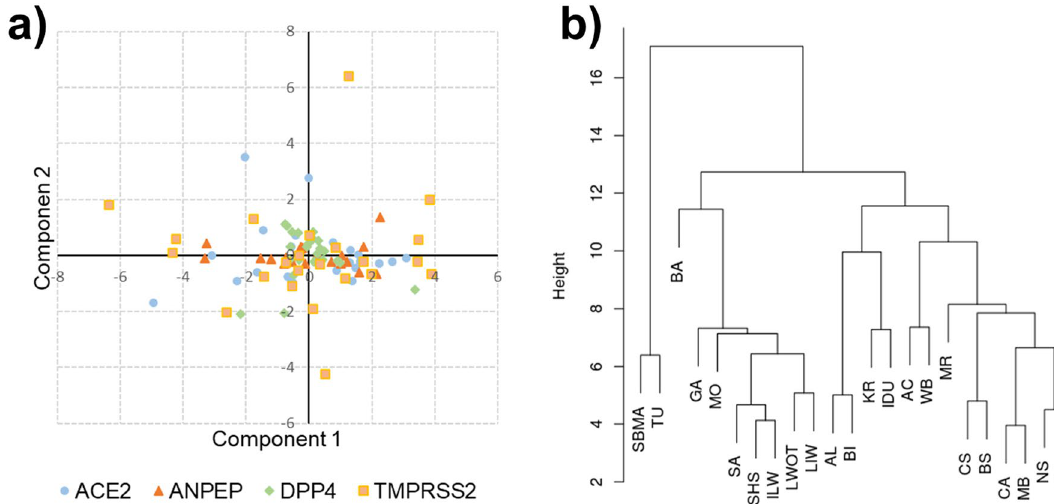
Figure 5. ( a ) Over-imposed multidimensional scaling (MDS) plots and ( b ) cluster analysis of European pig breeds and wild boars determined with information on the polymorphic sites in the ACE2 , ANPEP , DPP4 and TMPRSS2 genes. Acronyms of the breed name are given in Fig. 2 and Supplementary Table